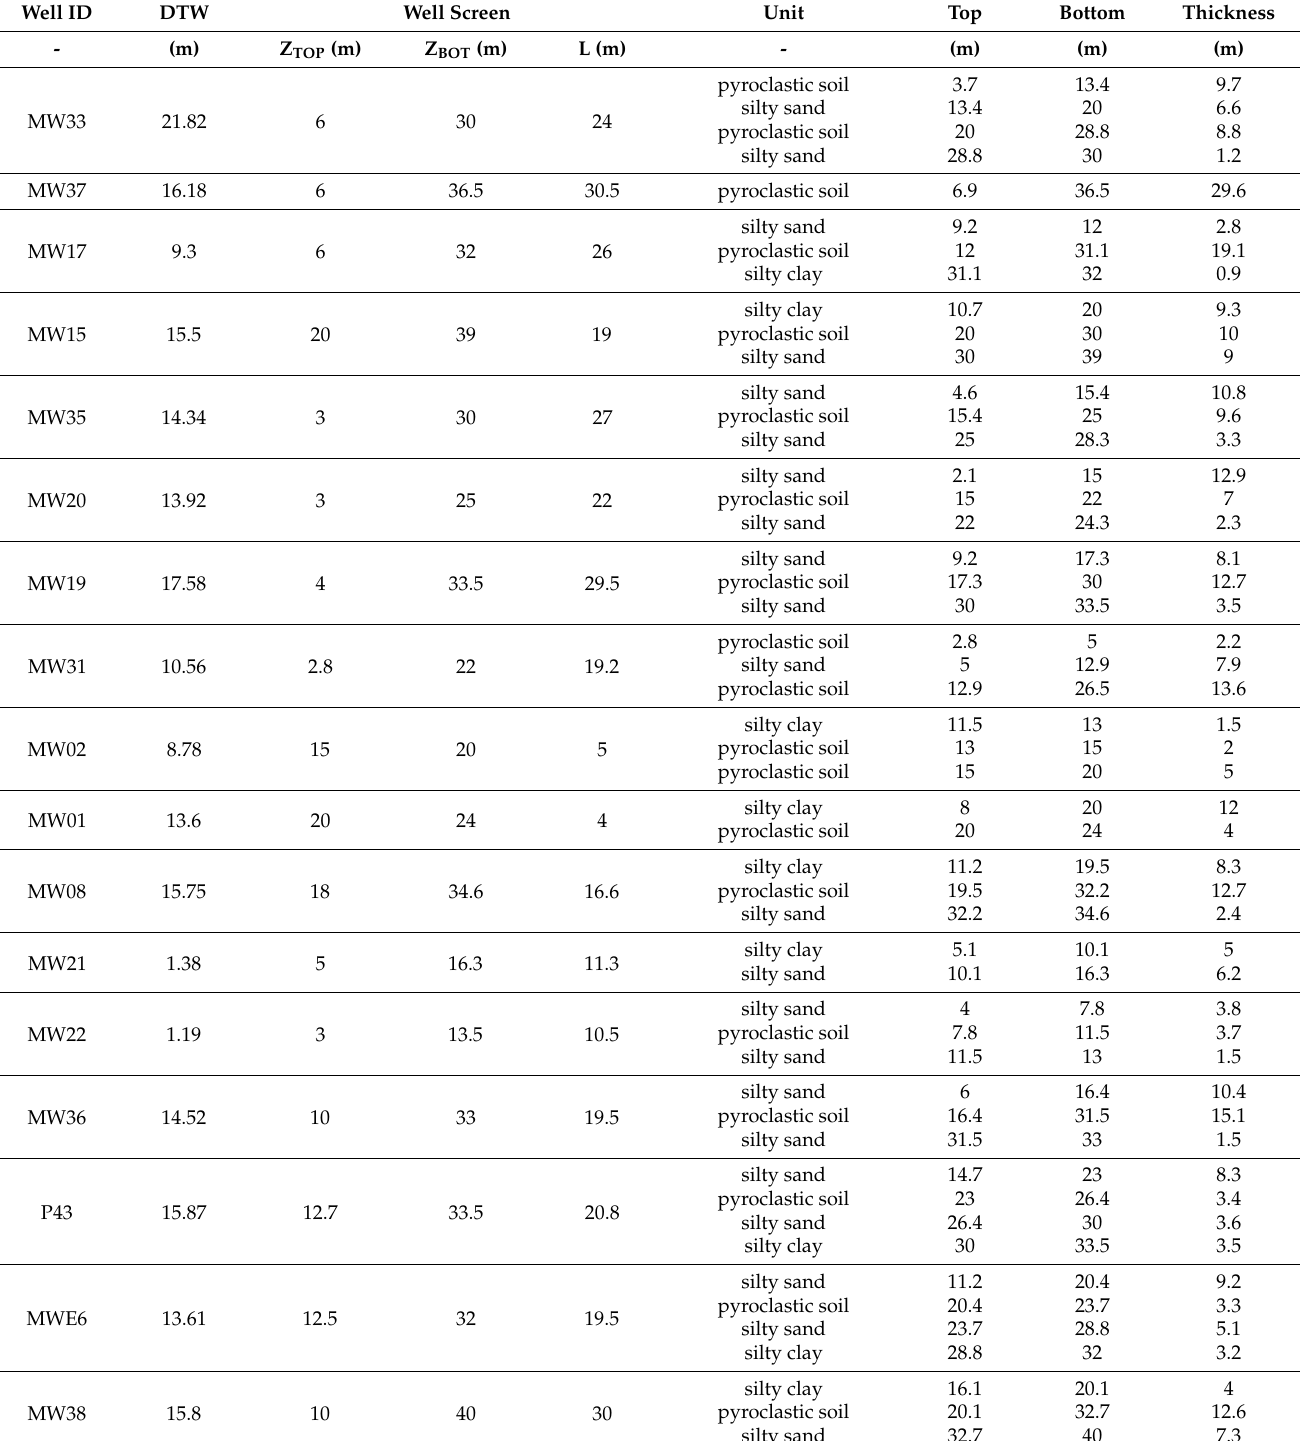
Table 2. Static depth to water (DTW) measurements, screen position and length, and stratigraphic data referred to monitoring